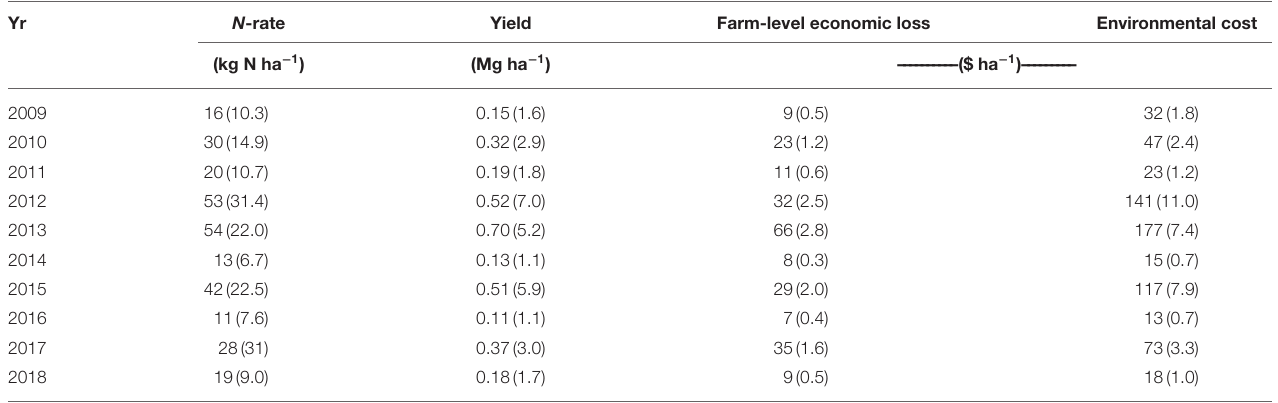
TABLE 2 | Reduction in nitrogen rates, yield, farm level economic loss, and environmental costs at EONR env relative to EONR. Yr N -rate